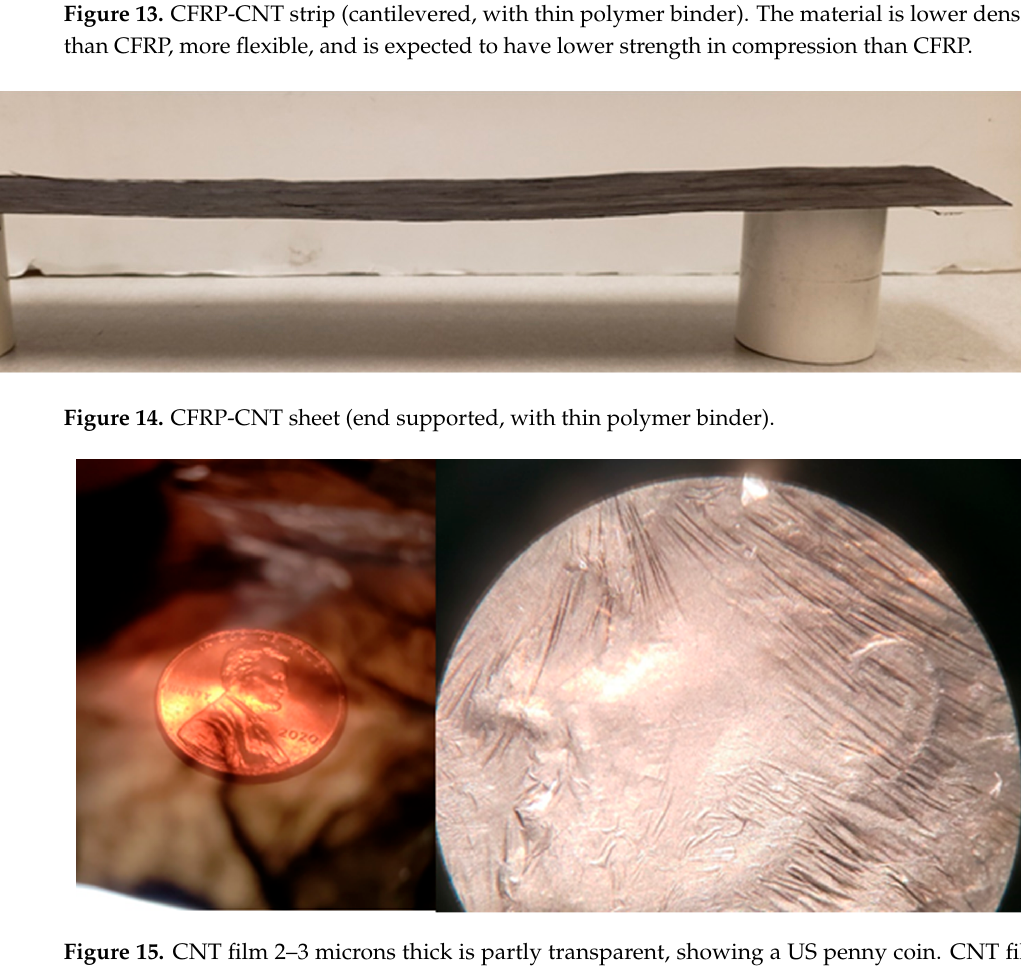
Figure 16. SEM image of chopped carbon fiber integrated into the intertangled web of CNT fabric.